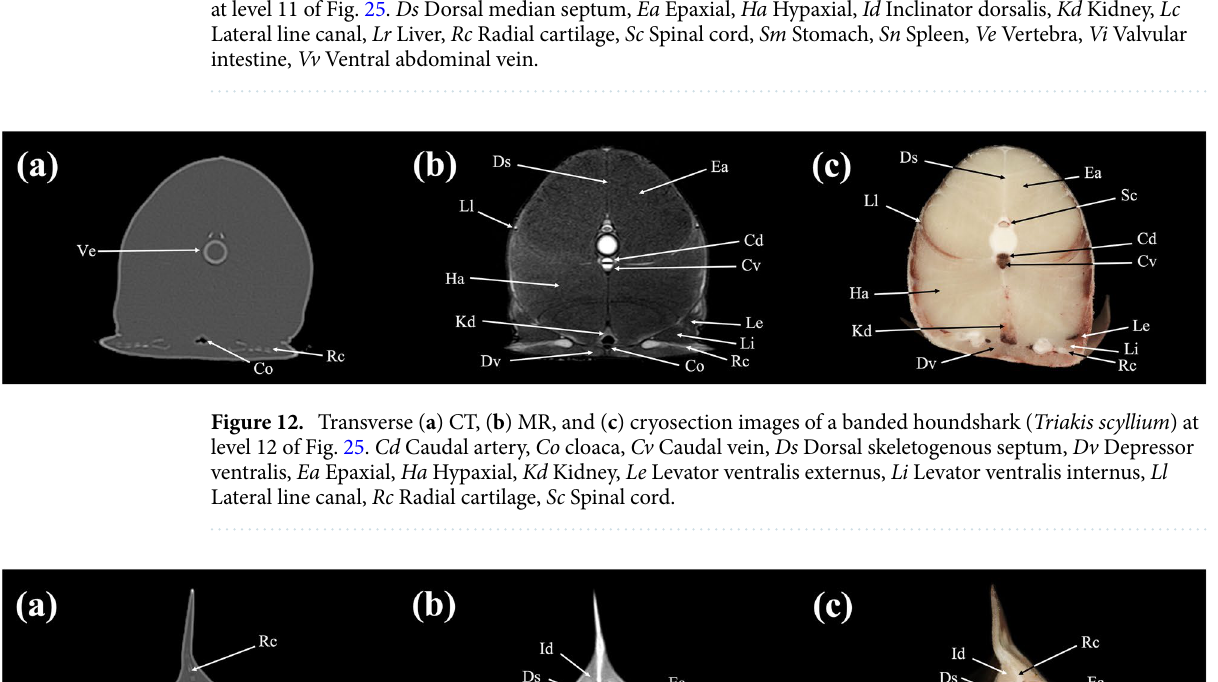
Figure 11. Transverse ( a ) CT, ( b ) MR, and ( c ) cryosection images of a banded houndshark ( Triakis scyllium ) at level 11 of Fig. 25. Ds Dorsal median septum, Ea Epaxial, Ha Hypaxial, Id Inclinator dorsalis, Kd Kidney, Lc